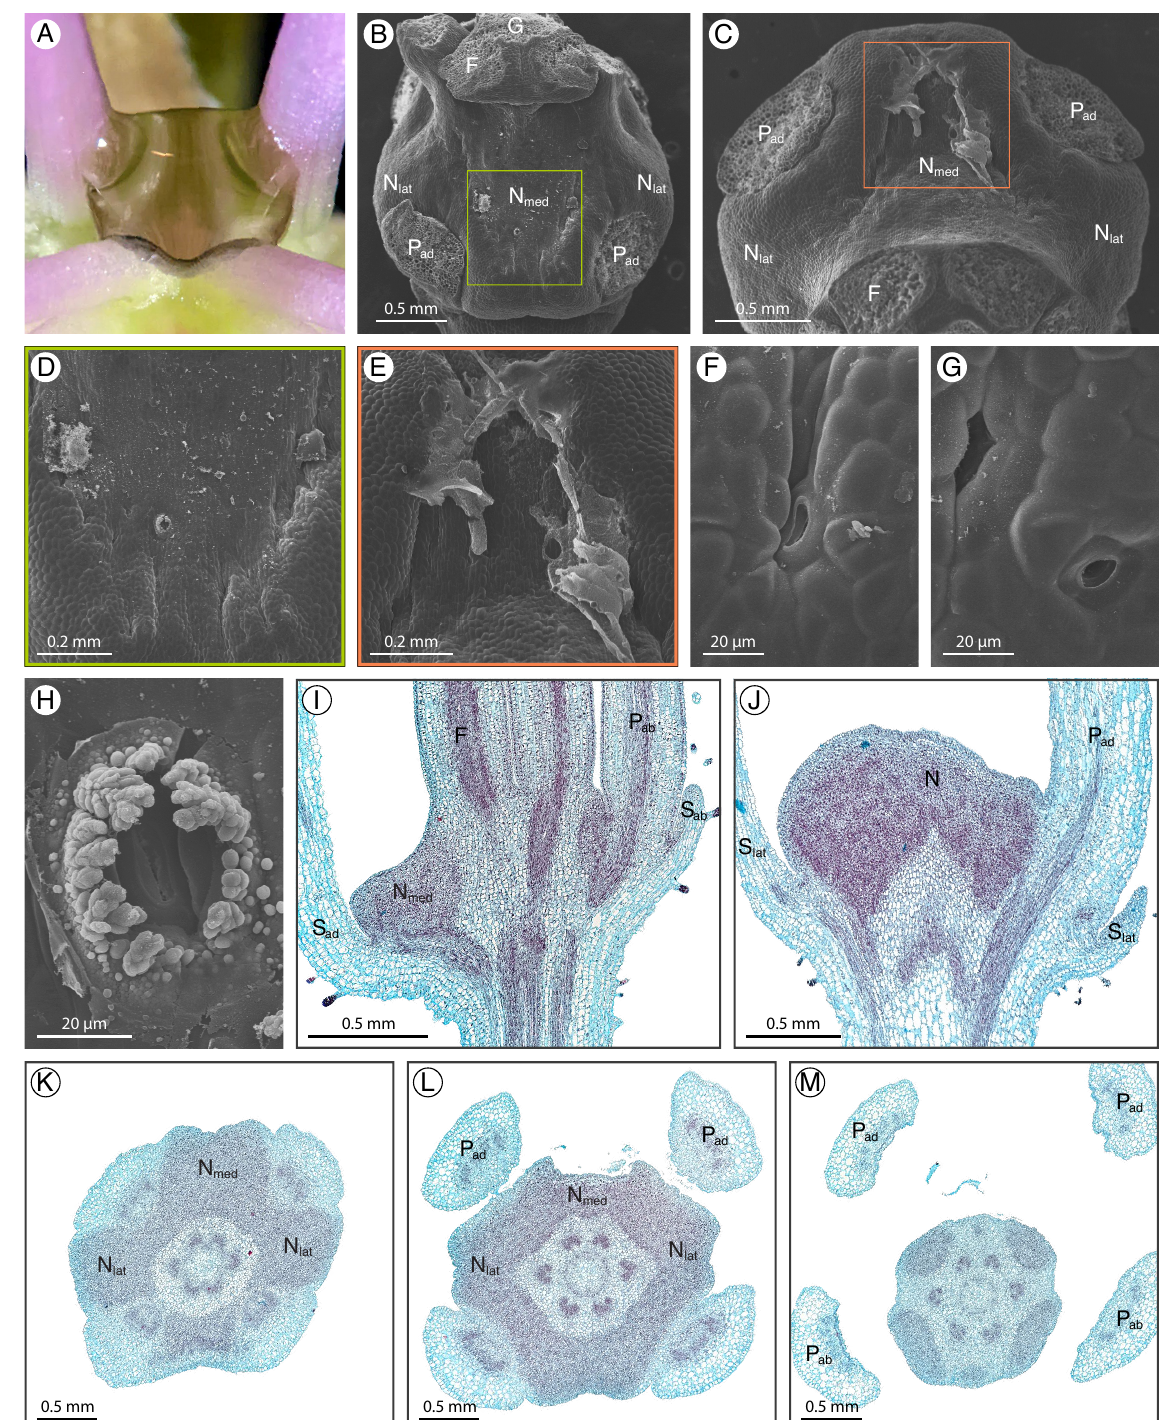
Figure 10. Tarenaya houtteana nectary ( A ) photograph, ( B – H ) scanning electron micrographs, and ( I – M ) fast green and safranin O-stained sections. ( A ) Apical view of the nectary. ( B ) Adaxial view of the nectary. ( C ) Apical view of the nectary. ( D ) Adaxial view close-up of the nectary, corresponding to the box in ( B ). ( E ) Apical view close-up of the nectary, corresponding to the box in ( C ). ( F – H ) Close-up of nectarostomata. ( I ) Longitudinal section (sagittal plane) of the bud stage nectary. ( J ) Longitudinal section (frontal-oblique plane) of the intermediate stage nectary. ( K – M ) Transverse sections of the nectary from proximal to distal positioning. All images are of anthetic stage specimens unless indicated otherwise. F: filament; G: gynophore; N lat : lateral nectary lobe; N med : medial nectary lobe; P ab : abaxial petal; P ad : adaxial petal; S ab : abaxial sepal; S ad : adaxial sepal; S lat : lateral